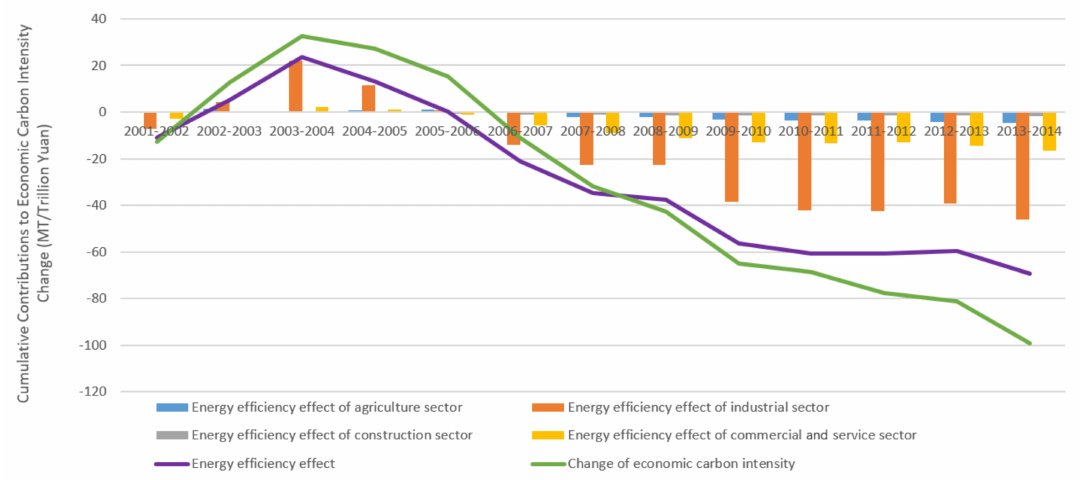
Figure 1. The Annual Contributions of Various Sectors’ Energy Efficiency to Economic Carbon Intensity Change.